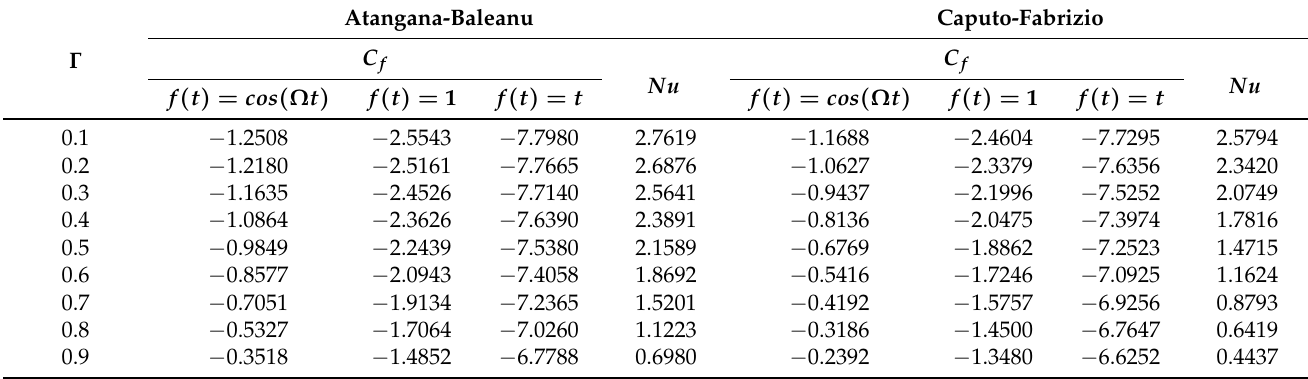
Table 3. Comparative numerical analysis of C f and Nu for fractional parameter Γ .